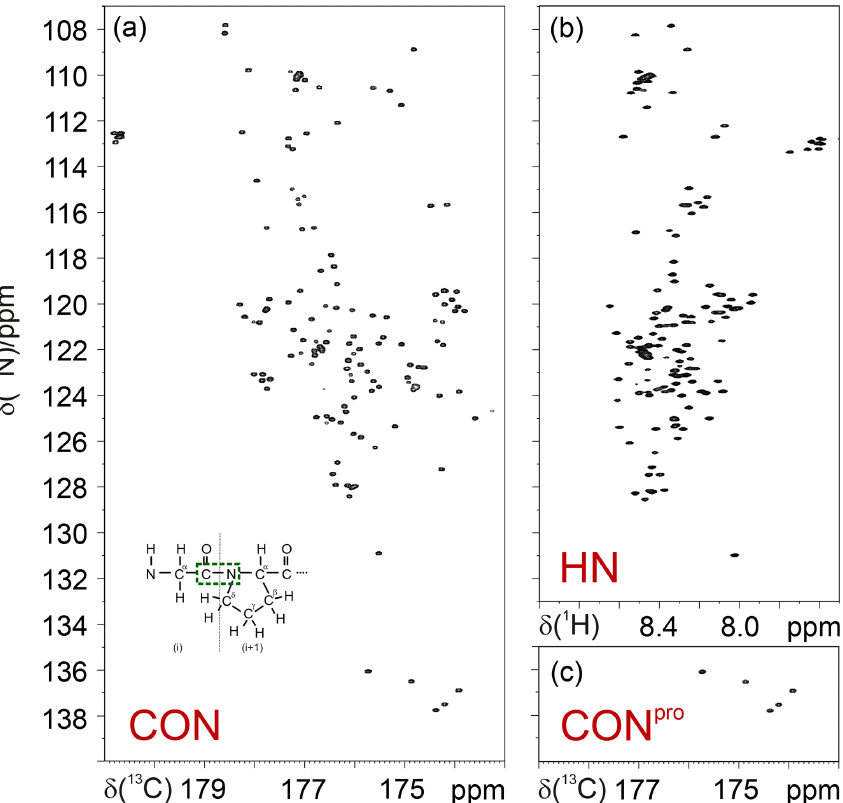
Figure 2. Comparison of the 2D CON (a) and 2D HN (b) spectra recorded on α -synuclein. The CON pro spectrum (c) , shown below the HN panel, clearly illustrates how this experiment provides the missing information with respect to that available in the HN-detected spectrum. In the inset of the 2D CON spectrum, a scheme of a Gly i − 1 − Pro i dipeptide highlights the nuclei that give rise to the C (cid:48) i − 1 − N i correlations detected in CON spectra (in